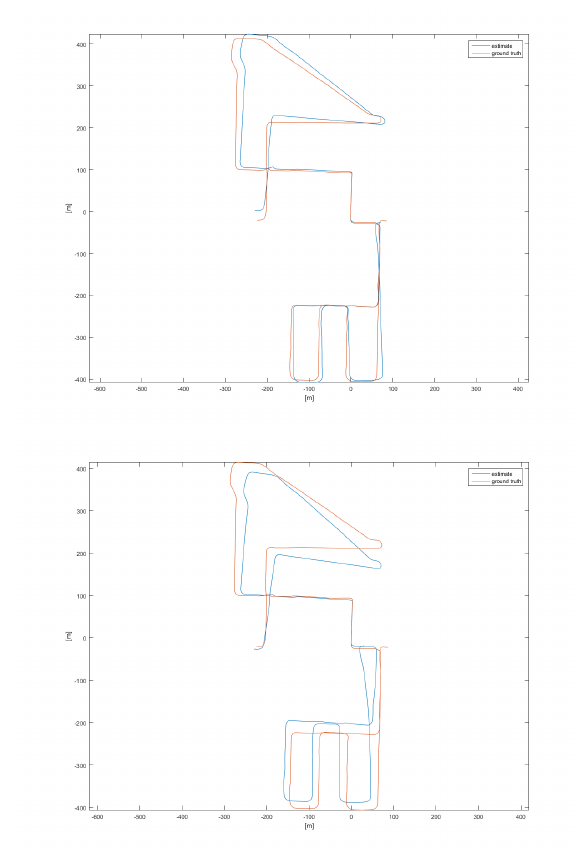
Figure 1. Tracking result for sequence 08 of the KITTI odometry challange (Geiger et al., 2012). Upper plot: full resolution input ( 1226 × 370 ). Lower plot: half resolution input ( 584 × 184 ). The trajectories are aligned at the middle of the sequence. We use a simple variant of ground plane estimation (cf. e.g. (Song and Chandraker, 2014)) to determine the absolute scale.